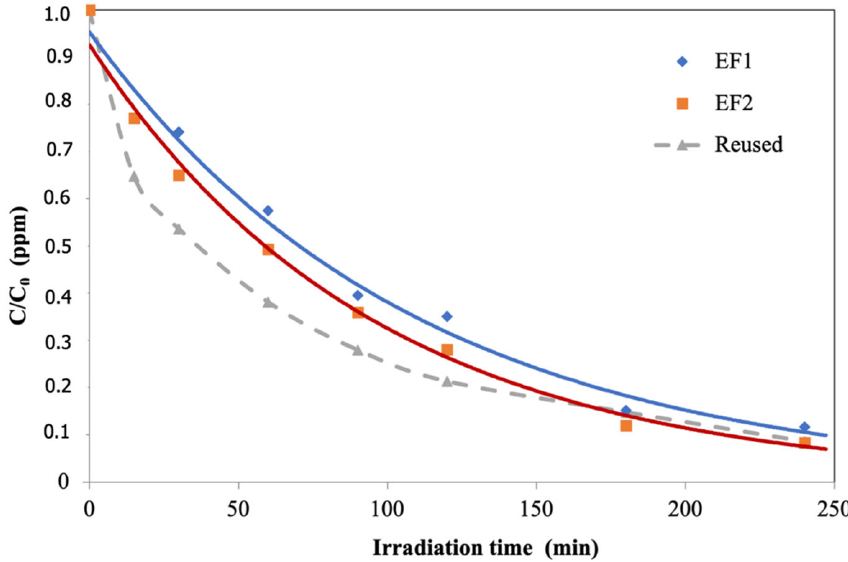
Figure 9. Contaminant in wastewater degradation by photocatalysis using black sand as photocatalyst under visible light. Experiments developed in a narrow pH range (EF1—5.80, EF2—5.84) and with reutilization of the photocatalytic material in several runs.